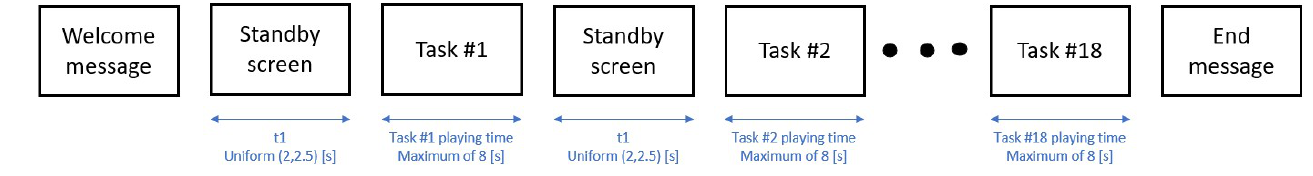
Figure 3. The experimental paradigm.